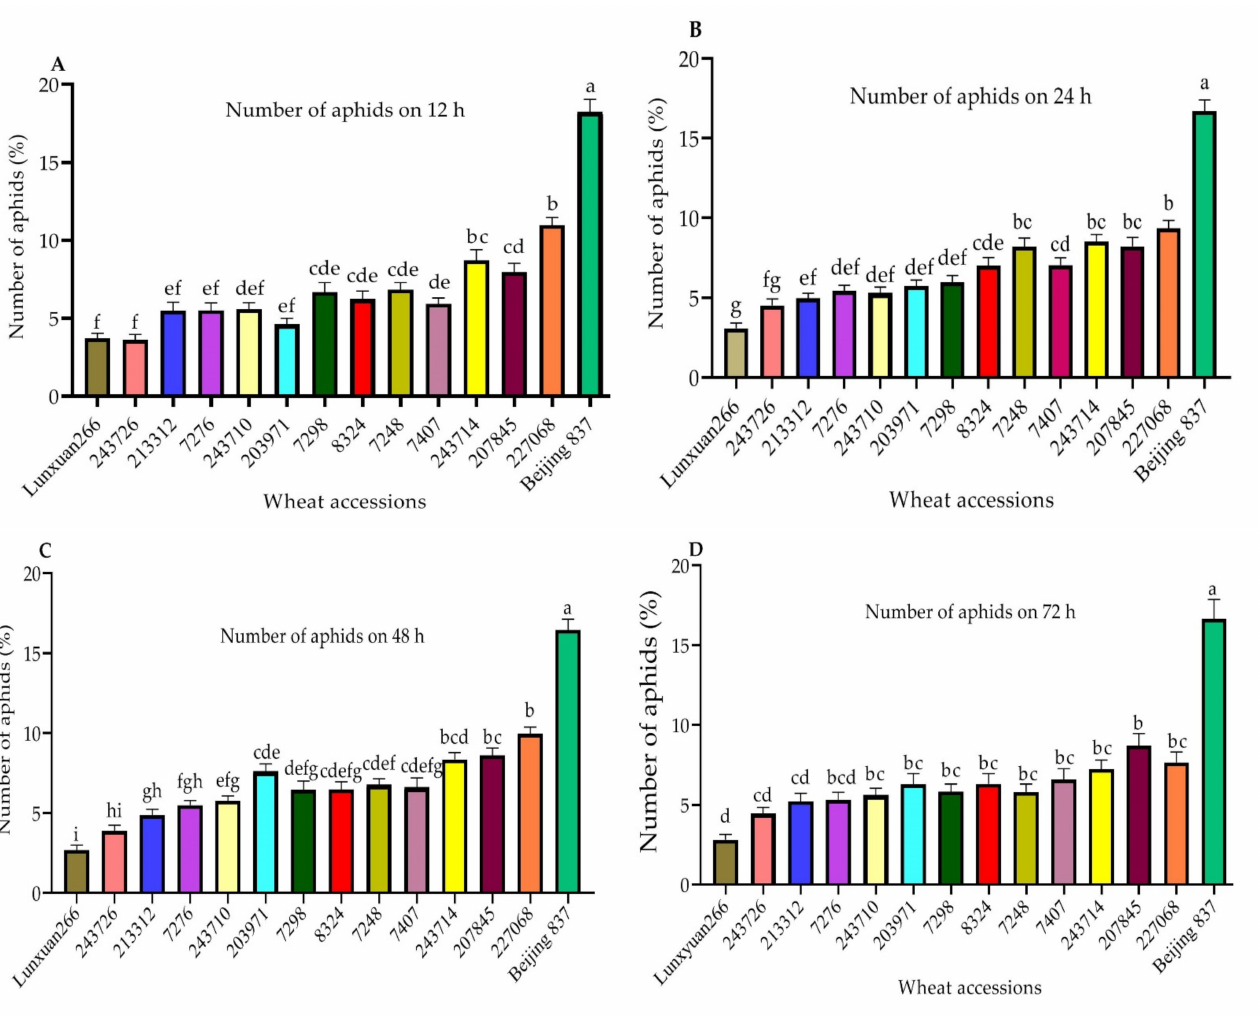
Figure 1. Percentage of winged S. miscanthi settled on the wheat accessions 12, 24, 48, and 72 h after being released. ( A – D ) indicate the percentage of winged S. miscanthi settled on wheat plants after 12, 24, 48 and 72 h, respectively. Bars represent the mean percentage of aphids settled (mean ± ME, n = 16). Different letters above the bars indicate significant